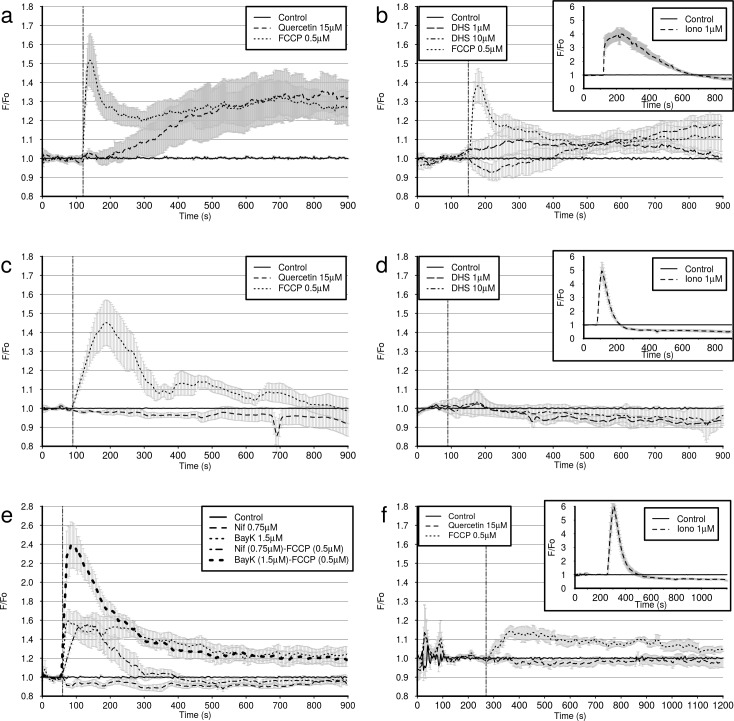
Confocal microscopy measurements of cytoplasmic [Ca++] (F/F0) in Fluo4 loaded H9c2 cells were used to further investigate the effects of quercetin, DHS and FCCP on Ca++ dynamics.After loading with 4 μM Fluo4-AM in HEPES, cells were unloaded in HEPES (a, b, e,), HEPES with 0.75 μM nifedipine (f), or Ca++ free HEPES (c, d). Subsequently cells were imaged in standard HEPES (a, b, e), calcium-free HEPES (c, d), or calcium-free, sodium-free medium (MiR05) with nifepidine (f). At the time point shown by the dashed vertical line, cells were treated with either DMSO (control) (a-f), 15 μM quercetin (a, c, f), 0.5 μM FCCP (a, b, c, f), 1 μM or 10μM DHS (b, d) or 0.75 μM Nifedipine (Nif), 1.5 μM Bay K 8644 (BayK), Nif + 0.5 μM FCCP, BayK + 0.5 μM FCCP (e). Cells were treated between 60s and 270s after the start of the experiment, as indicated by the dashed vertical line. Ionomycin (Iono), used as positive control, caused a rapid, and very strong increase in [Ca++] in all conditions (insets- b, d, f), but in Ca++ free medium there was a rapid loss of Ca++ back into extracellular medium (insets- d, f). Cells in MiR05 required a longer period of equilibration (270 s) (f), than other groups. Positive control experiment with cells treated with 1 μM ionomycin against DMSO treated cells (b, d, f; inset). Ionomycin causes a rapid influx of Ca++ into the cytosol.